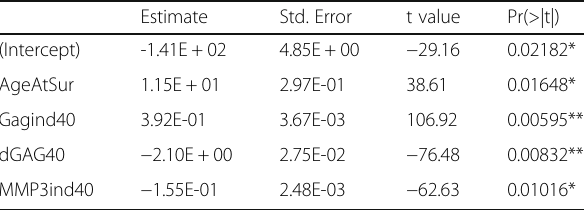
Table 2 Coefficients of multiple regression analysis for patient quality of life Estimate Std.